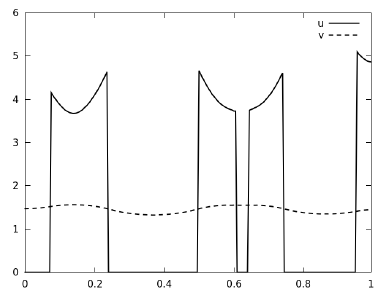
A discontinuous pattern with large